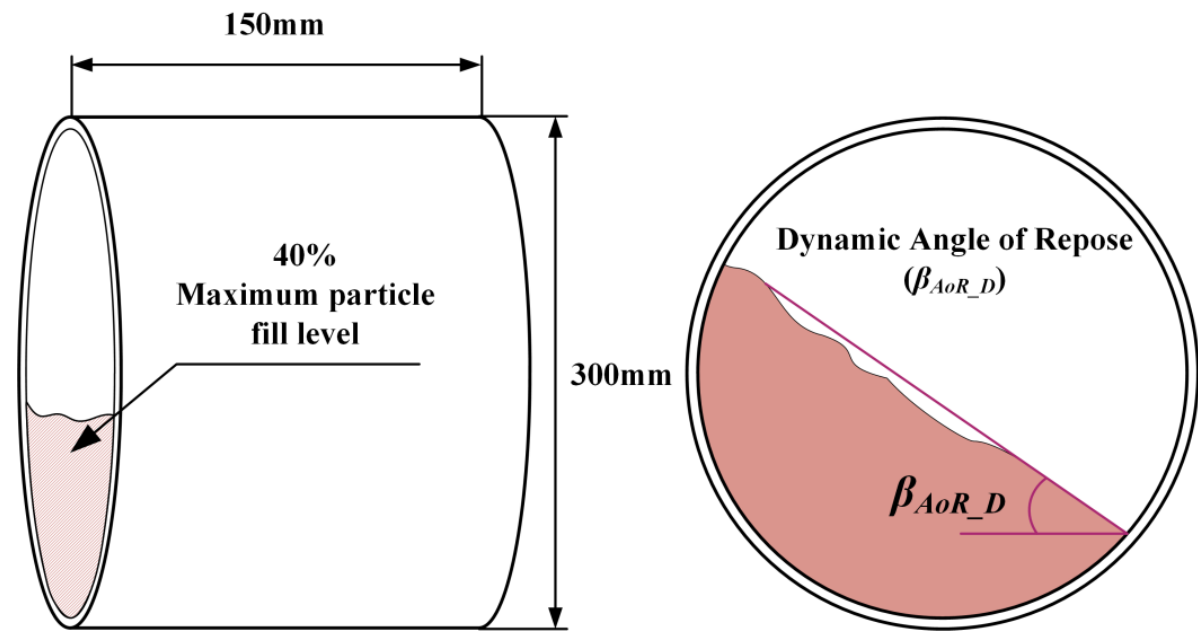
Figure 2. Principle of the rotary drum test.